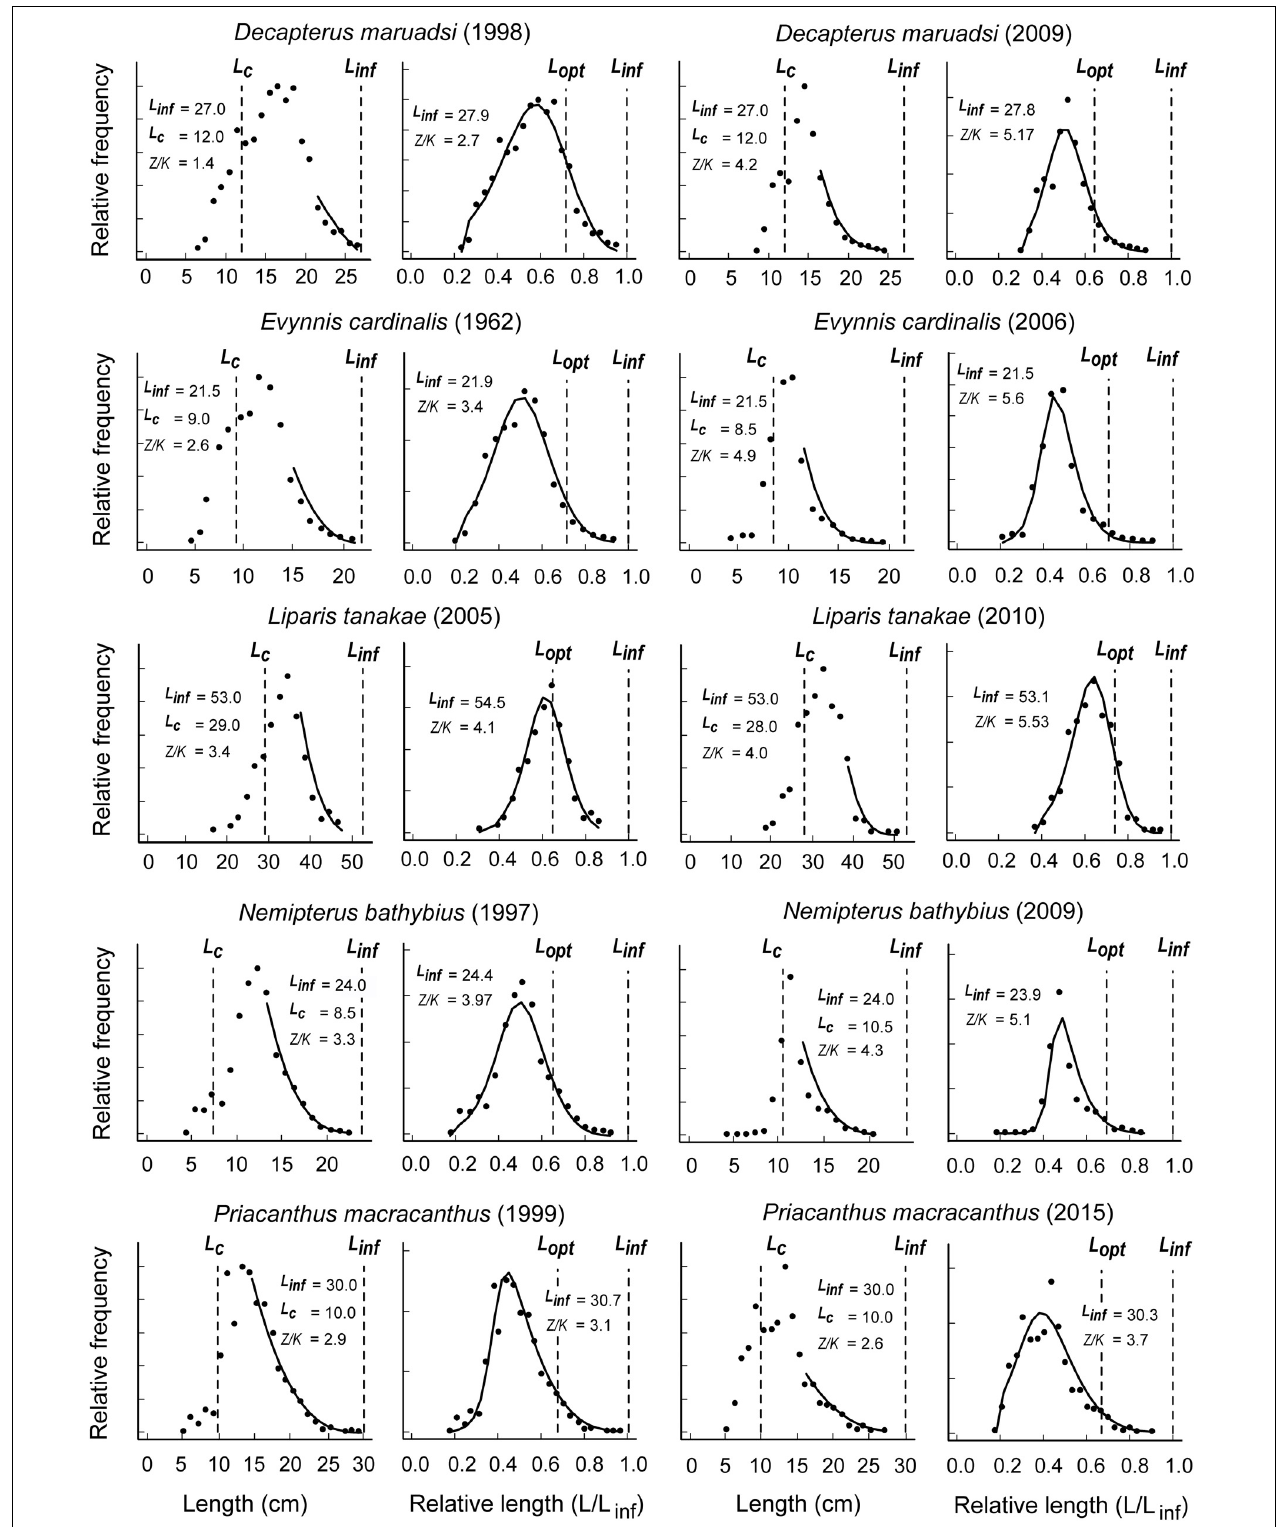
FIGURE 3 | Application of the LBB method to 5 species of commercially exploited fish along the coast of China (Japanese scad Decapterus maruadsi , threadfin porgy Evynnis cardinalis , Tanaka’s snailfish Liparis tanakae , yellowbelly threadfin bream Nemipterus bathybius , and red bigeye Priacanthus macracanthus ) and for with length-frequency data were obtained from two different time periods from Geng et al. (2018), Chen et al. (2012, 2013), and Zhang et al. (2016a,b); see Table 1 and Supplementary Tables S1, S2 .